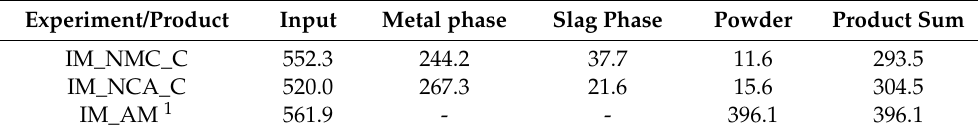
Table 3. Masses of the input sample and the obtained products in InduMelt experiments. (g). Experiment/Product Input Metal